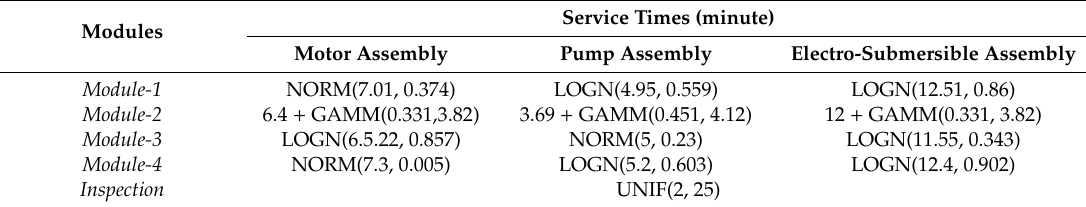
Table 5. Simulation